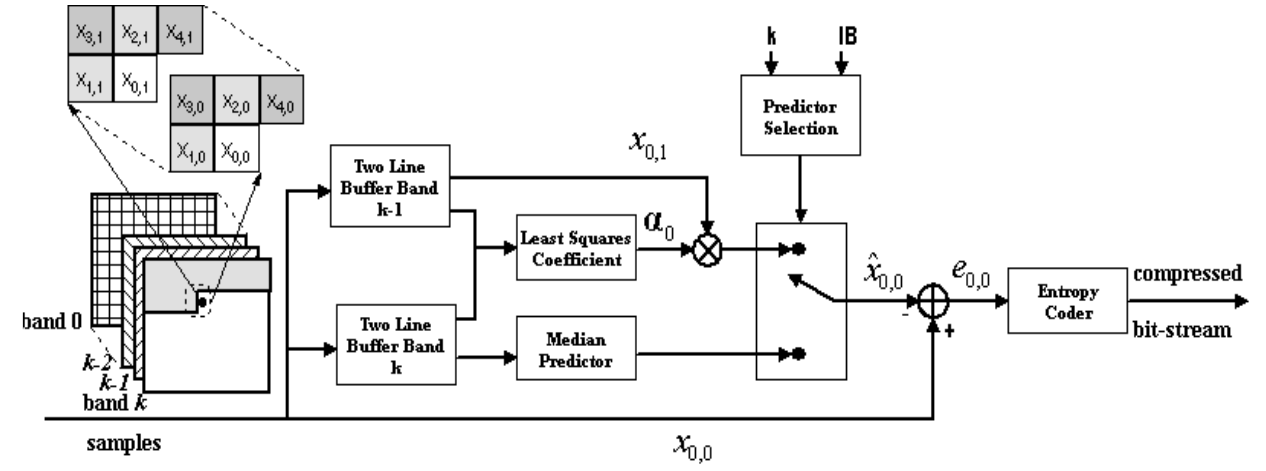
Figure 8. Spectral oriented Least SQuares (SLSQ) block diagram (from